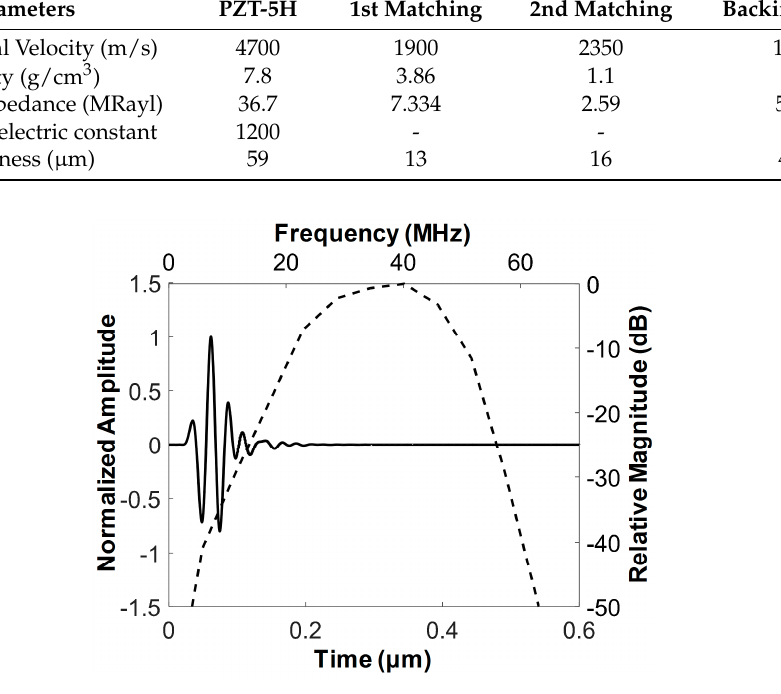
Figure 2. Pulse-echo response (solid line) and its frequency spectrum (dashed line) obtained by simulation using a PiezoCAD program (Sonic Concept, Woodinville, WA, USA).